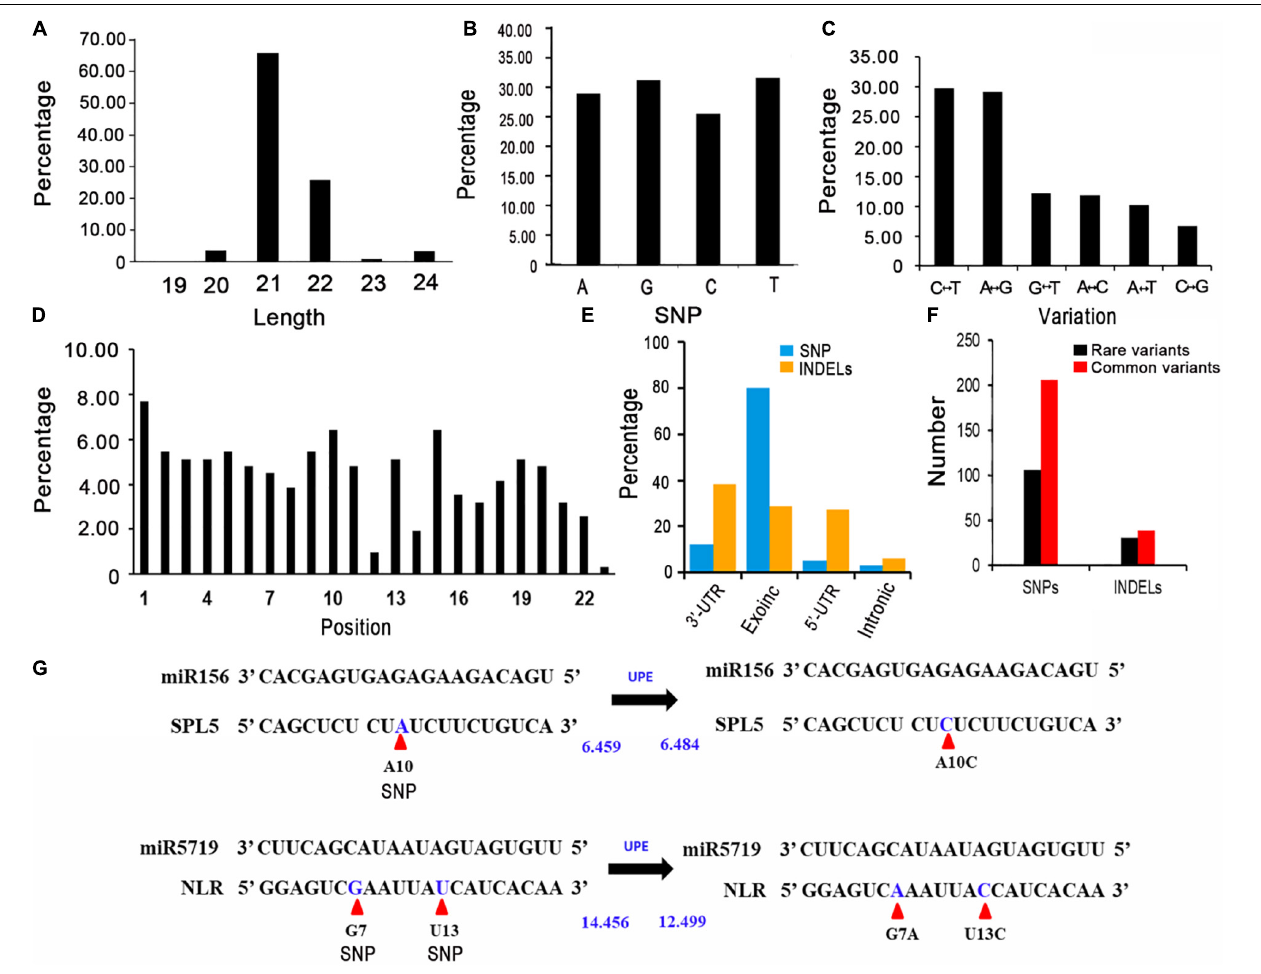
FIGURE 2 | Features of the variants in miRNA target sites. (A) Length distribution of putative miRNA target sites. (B) Percentages of the A, G, C, and T variations. (C) Percentages of the different types of nucleotide substitutions among the SNPs. C ↔ T: C to T or T to A substitution; G ↔ A: G to A or A to G substitution; C ↔ T: G to T or T to G substitution; A ↔ C: A to C or C to A substitution; A ↔ T: A to T or T to A substitution; C ↔ G: C to G or G to A substitution. (D) Percentage of SNPs in each miRNA target site. (E) Annotation of the variants identified in miRNA target sites. (F) Number of rare and common variants in miRNA target sites. (G) Altered target binding caused by genetic variants within miRNA target sites. UPE: target accessibility energy to unpair the target site (kcal/mol); decreases in energy increase the possibility that small RNAs will be able to interact with (and cleave) target mRNAs. Allelic SNPs are presented in blue and are marked by red arrows. UPEs are calculated using